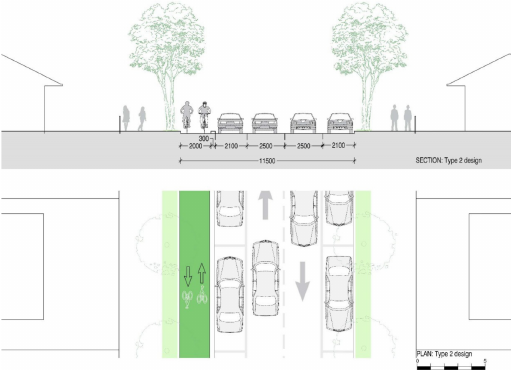
Figure 7. Section and plan drawings showing proposed retrofit ‘Design 2A’ for a reconfigured ‘Type 2’ street including a 2 m two-way cycling lane and 0.3 m wide physical barrier with similar roadway, but 2.1 m parking lanes on either side of the streets and two-way single traffic lanes of 2.5 m width to accommodate 40 km/h speed